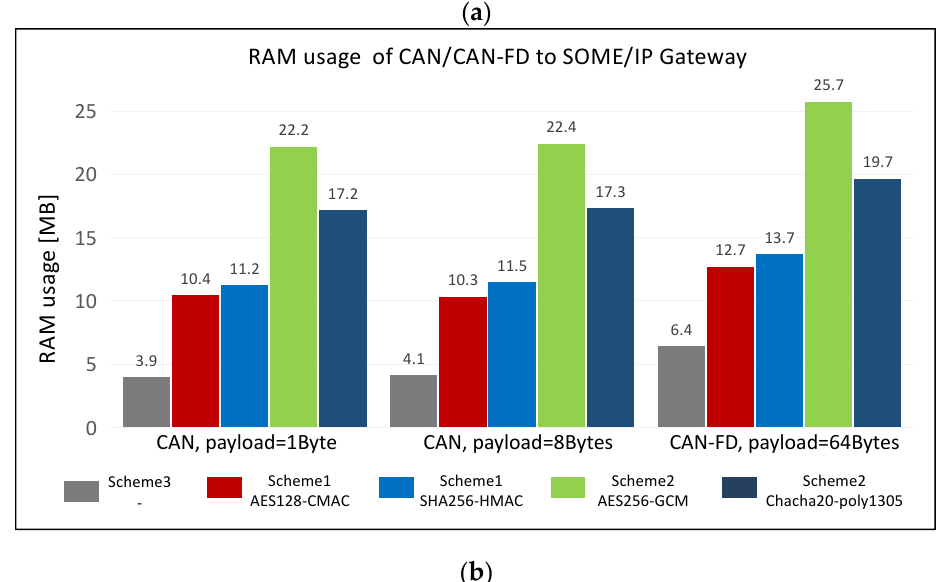
Figure 13. The system resource overhead of the designed gateway: ( a ) CPU usage; ( b ) RAM usage. The designed gateway consumes a low amount of CPU and RAM in all experimental groups. The peak value of CPU usage is 5.9%. This value would increase in other devices due to the powerful performance of NXP-S32G compared to that of other embedded devices. The peak RAM usage is 25.7 MB. This value is completely acceptable for gateway devices or domain controllers that run the Linux operating